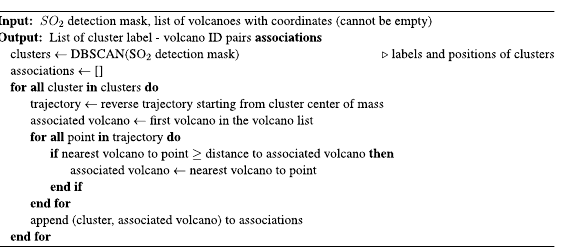
ALGORITHM 2. Multi-class Reverse Trajectory DBSCAN